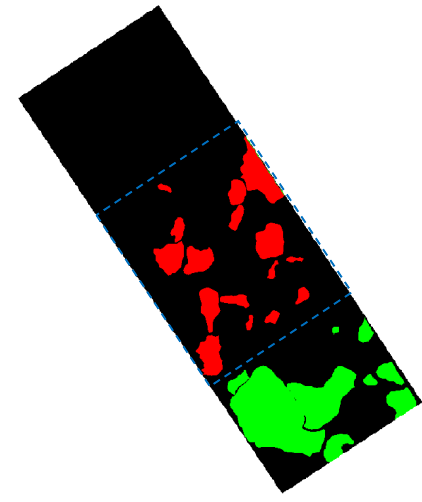
Figure 12. The model training area (blue rectangle) with the landslide inventory used for the training (red polygons). The landslides depicted with green polygons were used for the accuracy assessment.